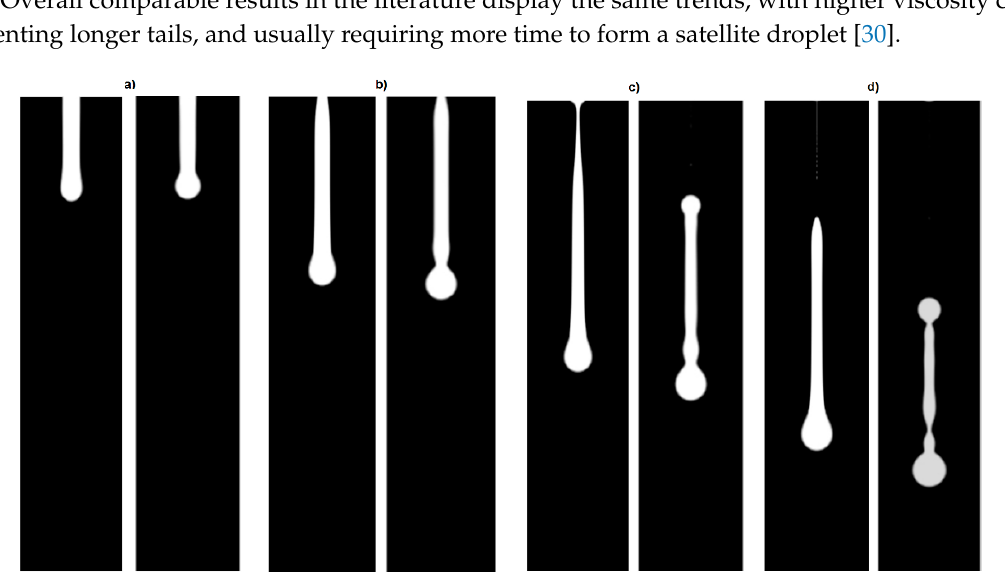
Figure 4. Comparison between viscosity values at the following four time steps: ( a ) 6 μ s, ( b ) 12 μ s, ( c ) 18 μ s, and ( d ) 24 μ s.